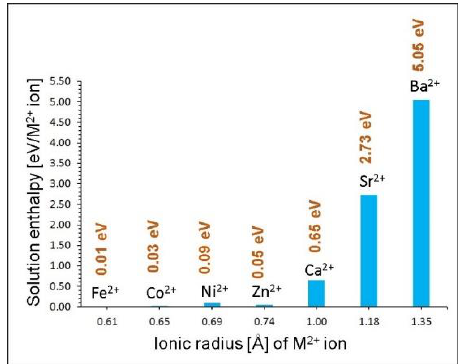
Figure 5. Enthalpy of solution of MO, (M = Fe, Co, Ni, Zn, Ca, Sr and Ba) with respect to the M 2+ ionic